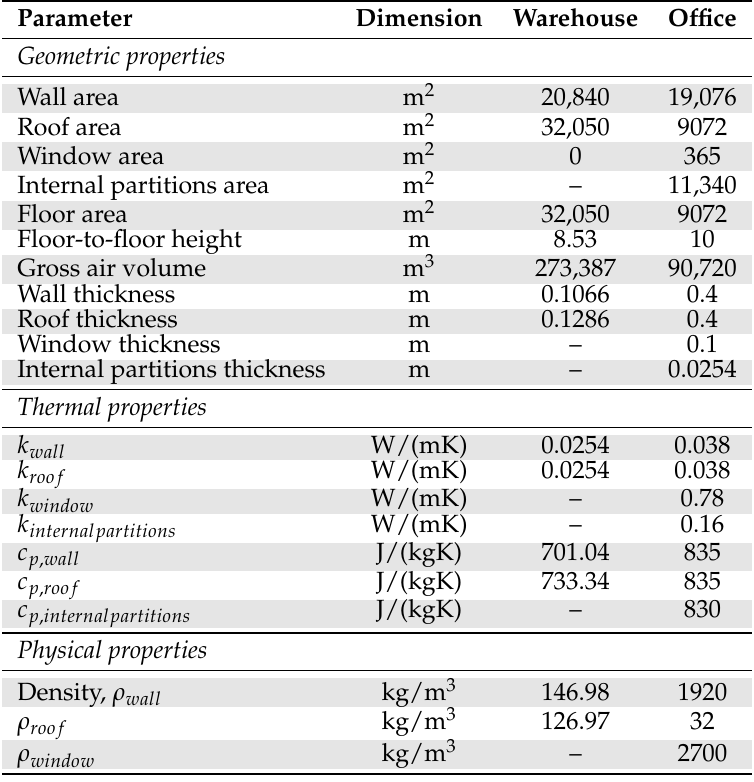
Table A1. Building parameters.